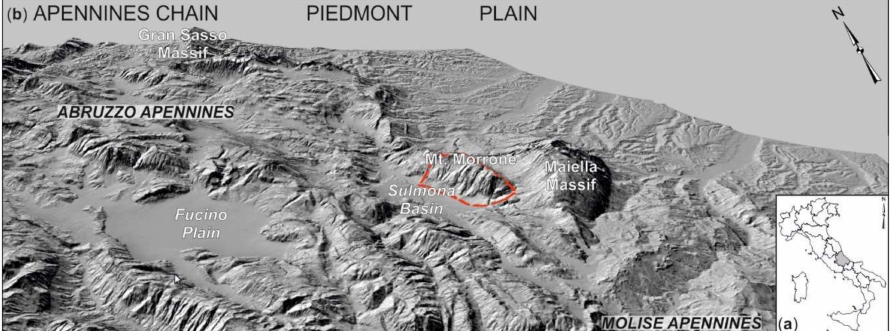
Figure 1. ( a ) Location map of the study area in Central Italy; ( b ) three-dimensional view (from 20 m DEM, SINAnet) of the Abruzzo Region. The red dashed line indicates the location of the study